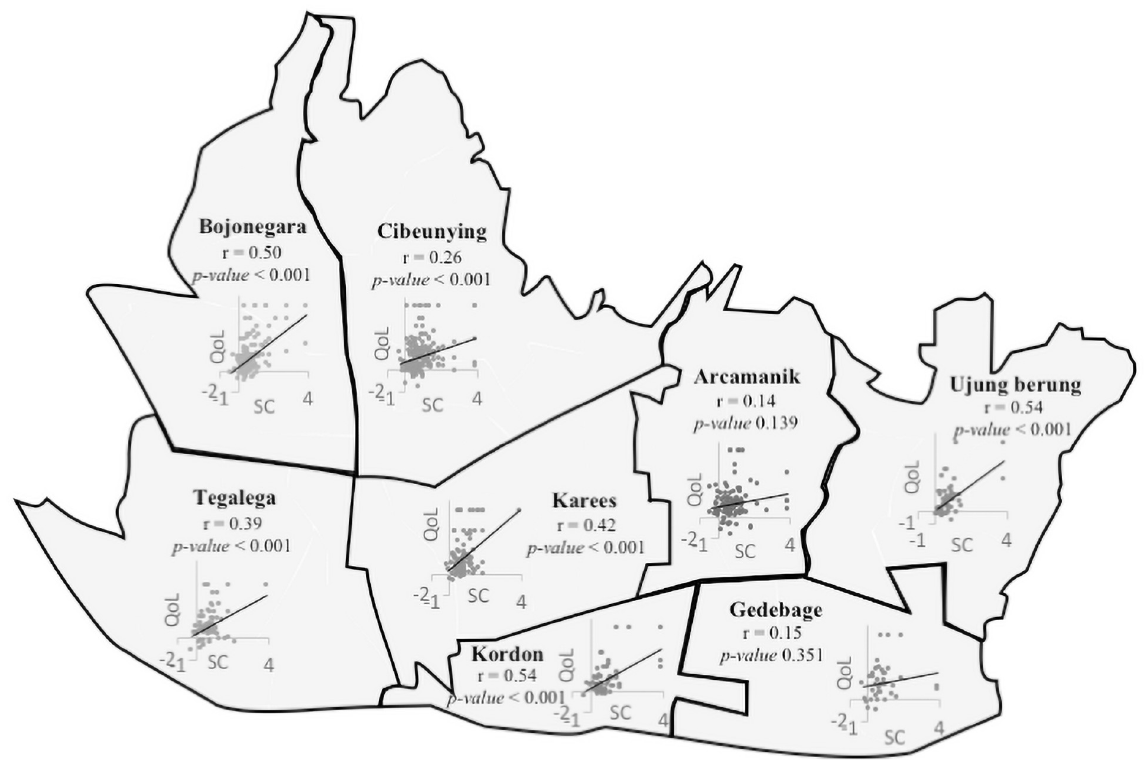
Fig 2. Correlation of social cohesion and quality of life in the eight subregions of Bandung City. SC = social cohesion; QOL = quality of life. This figure was drawn by the first author (SAP) using Microsoft PowerPoint. The figure is only provided for illustrative purposes.